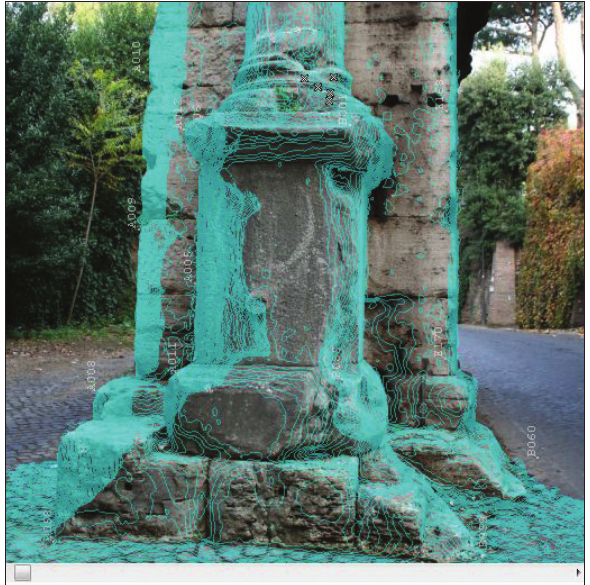
8. Photomodeler screenshot: restitution of South façade left plinth, superimpotion of survey model and photo